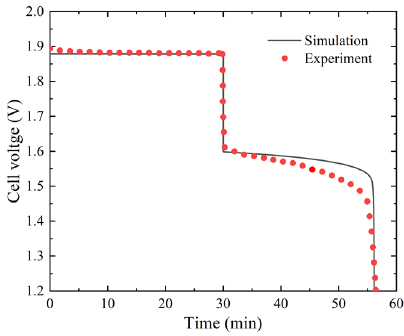
Figure 3. Simulated voltage of ZBFB at a current density of 20 mA cm − 2 compared with the experi- mental voltage.